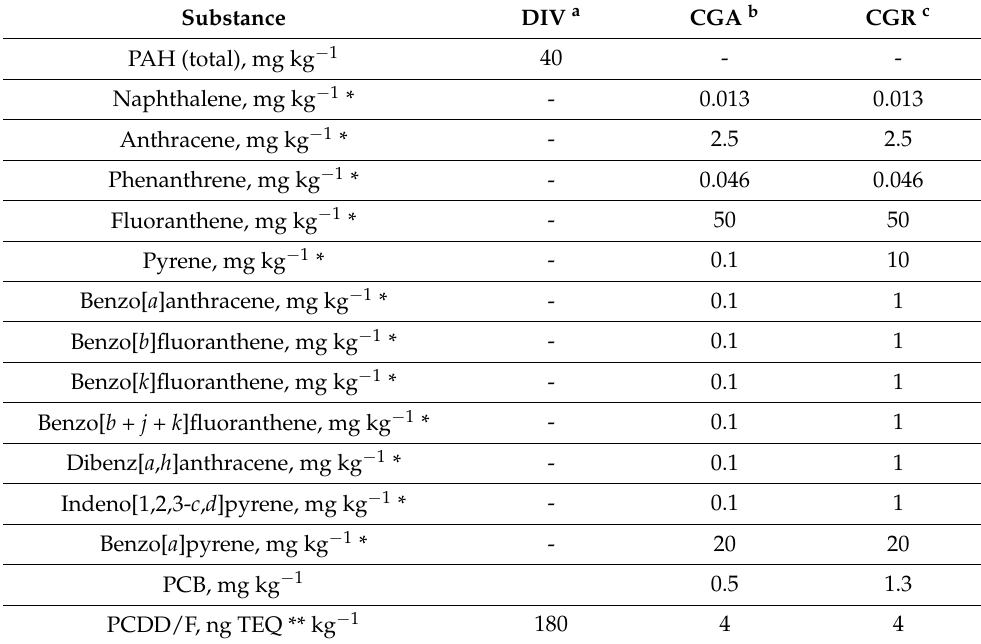
Table 9. Dutch and Canadian guidelines for PAH, PCB, and PCDD/F concentrations in soils.